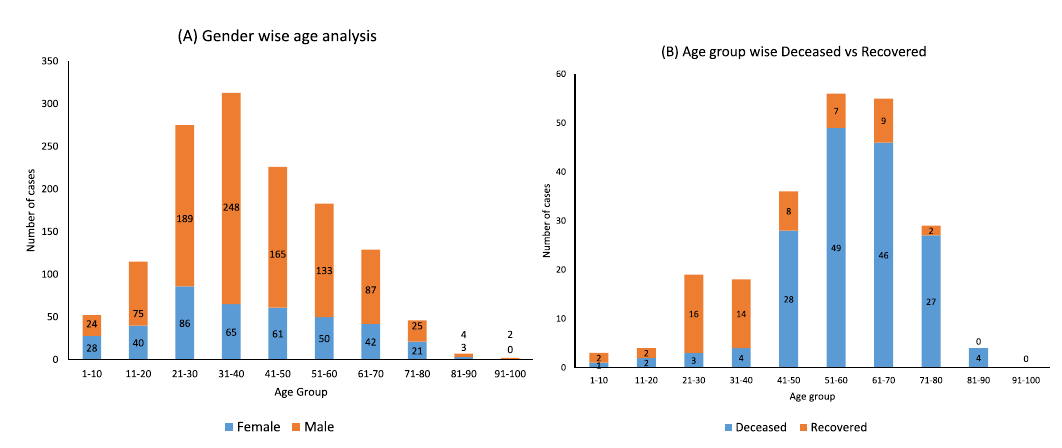
Fig. 6. Age analysis; (A) Gender wise age analysis with confirmed cases, (B) Age analysis with deceased and recovered cases